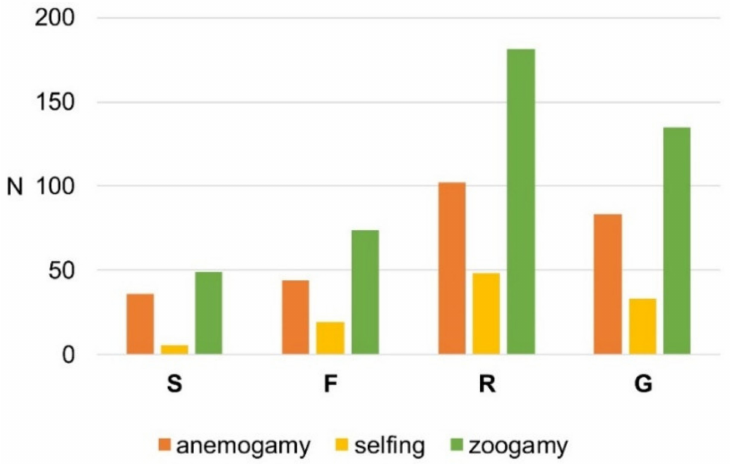
Figure 6. Number of species with the main types of pollination (S—open swimming pools, F—multi- media fountain, R—reservoir, G—gravel pit lake).